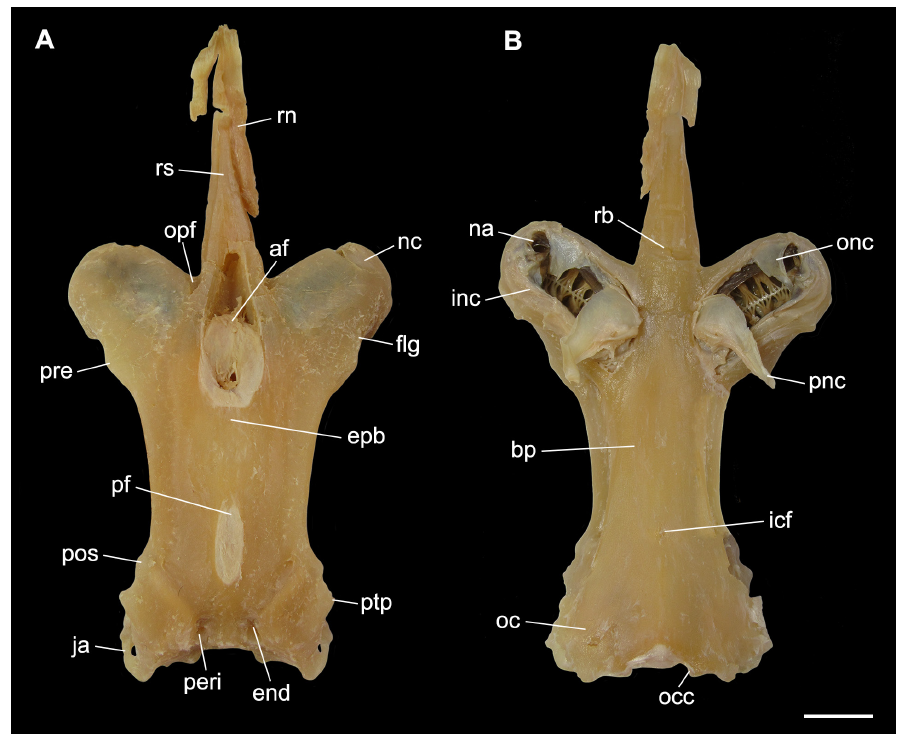
FIGURE 5 | Neurocranium of Atlantoraja castelnaui , UERJ 1853, male, 593 mm TL. A. Dorsal view. B. Ventral view. af , anterior fontanelle; bp , basal plate; end , endolymphatic foramen; epb , epiphysial bridge; flg , flange; icf , internal carotid artery foramen; inc, inner nasal cartilage ja , jugal arch; na , nasal aperture; nc , nasal capsule; oc , otic capsule; occ , occipital condyle; onc , outer nasal cartilage; opf , ophthalmic foramen; peri , perilymphatic foramen; pf , posterior fontanelle; pnc , posterior nasal cartilage; pos , postorbital process; pre , preorbital process; ptp , pterotic process; rb , rostral base; rn , rostral node; rs , rostrum. Scale bar = 10 mm.